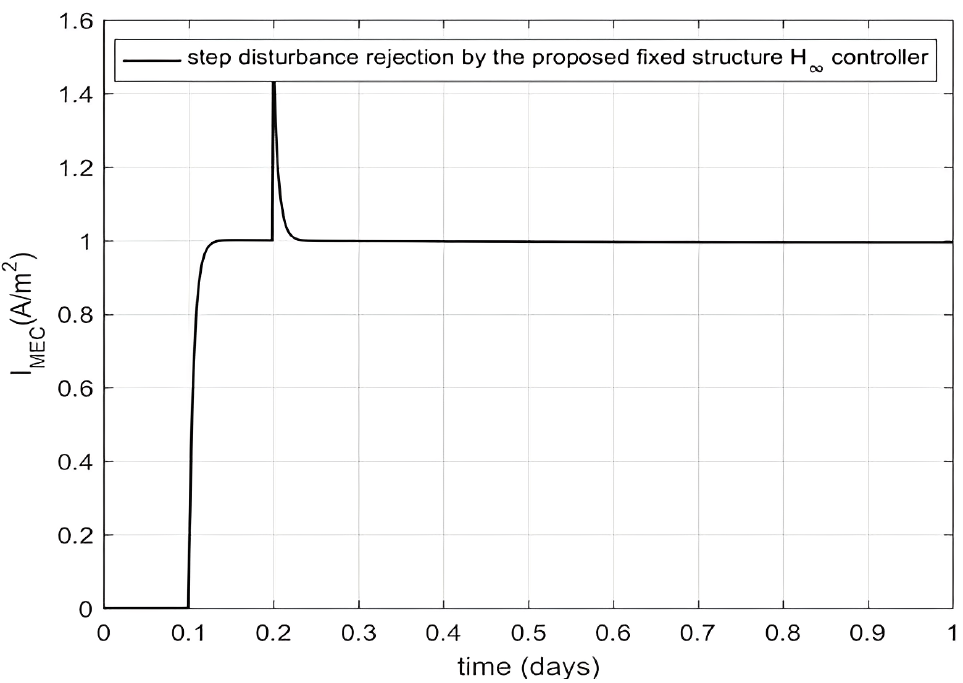
Figure 13. Plot of the proposed controller’s response to step-disturbance